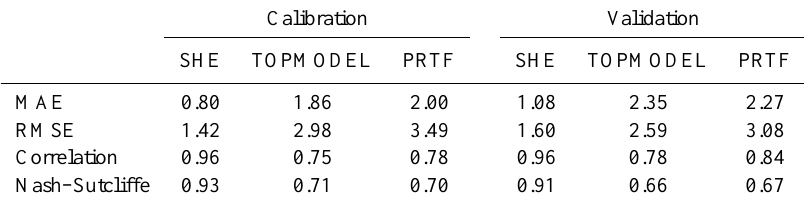
Table 3. Model performances in calibration and validation for the Upper Medway Catchment.